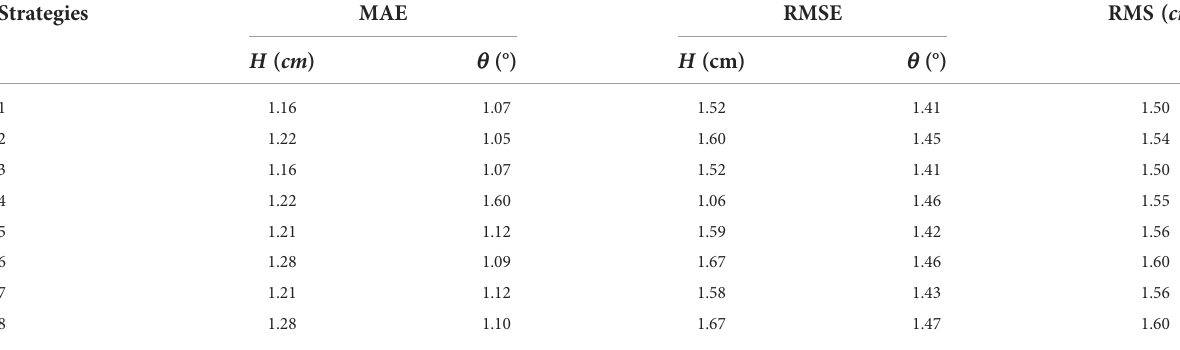
TABLE 4 Differences between SOs and re-estimated HCs of M 2 constituent. Strategies